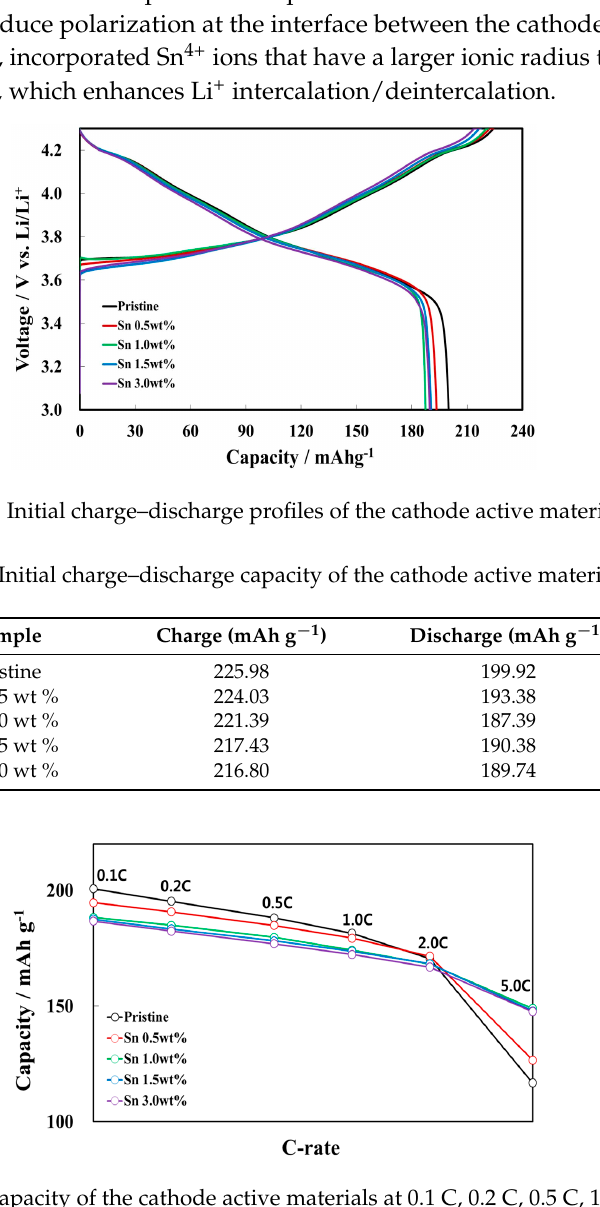
Figure 6. Discharge capacity of the cathode active materials at 0.1 C, 0.2 C, 0.5 C, 1 C, 2 C, and 5 C.